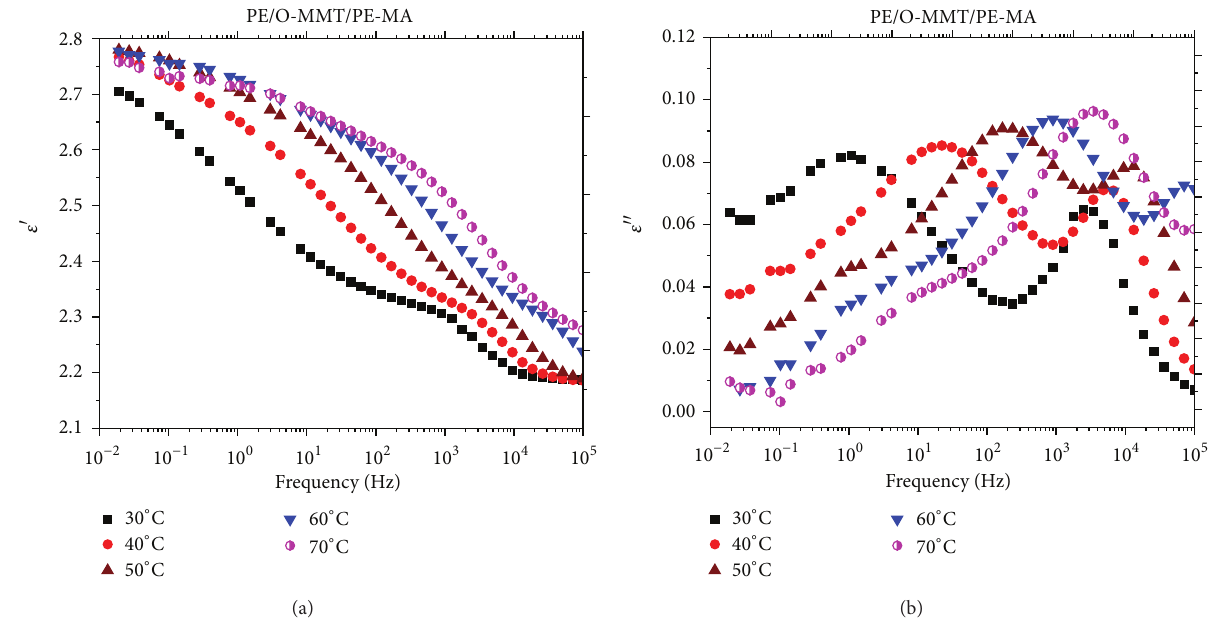
Figure 9: Relative permittivity 𝜀 󸀠 (a) and dielectric loss 𝜀 󸀠󸀠 (b) for PE/O-MMT/PE-MA nanocomposites versus frequency at different temperatures.